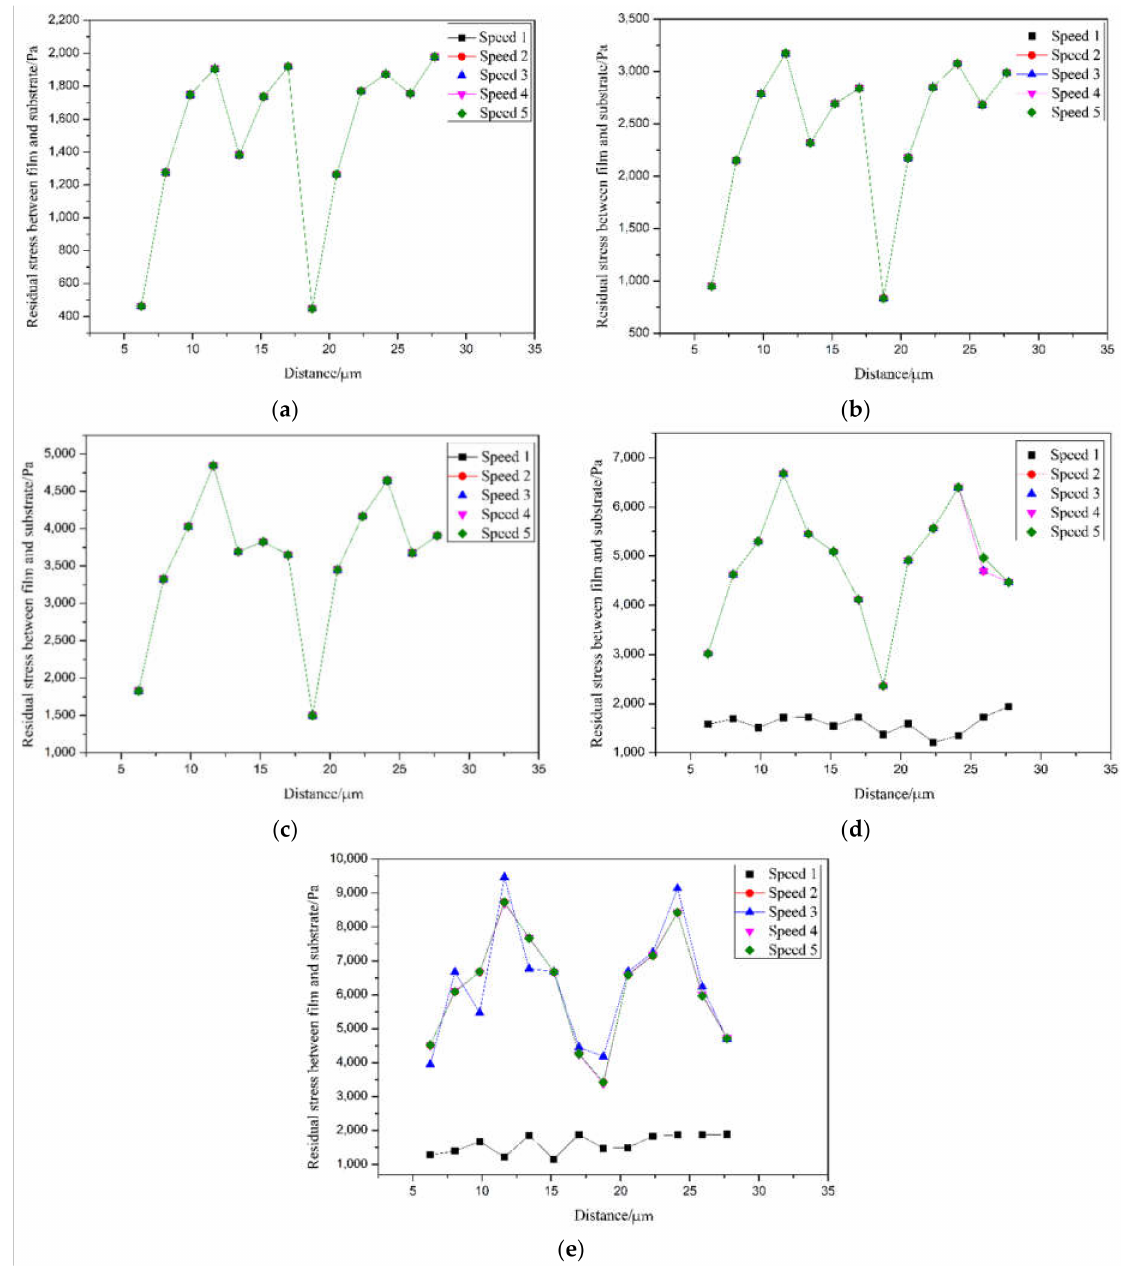
Figure 5. Speed–stress curve. ( a ) t = 60 nm; ( b ) t = 100 nm; ( c ) t = 150 nm; ( d ) t = 200 nm; ( e ) t = 250